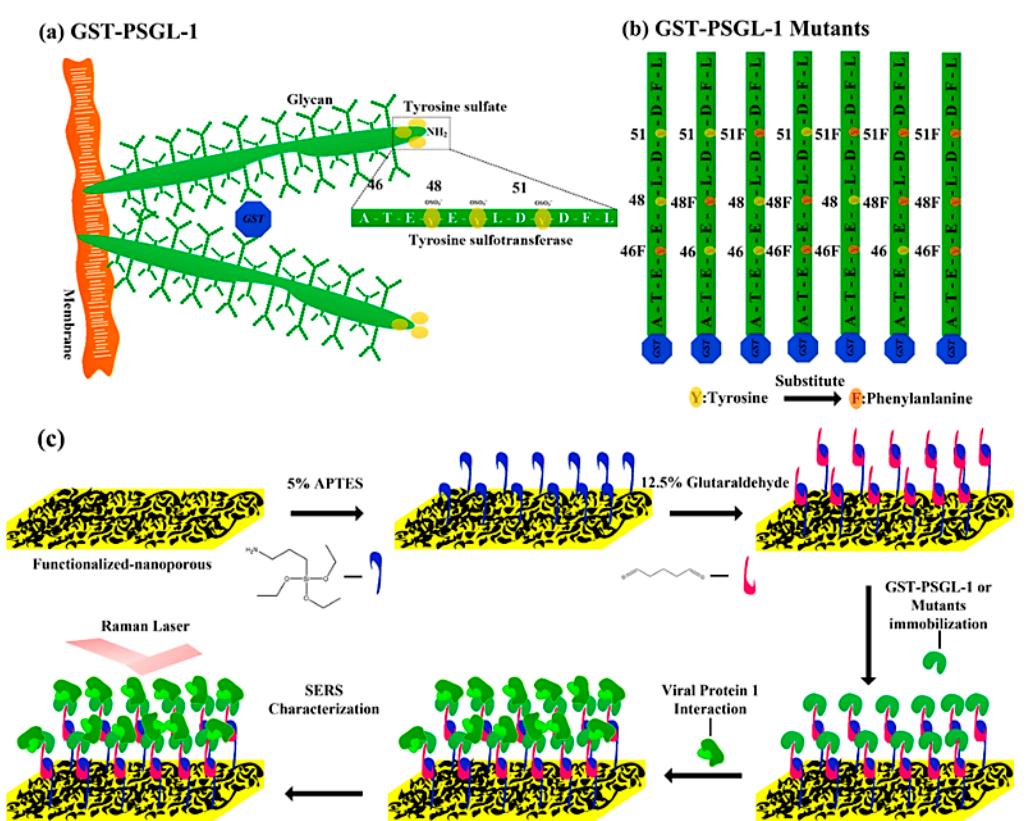
Figure 1. ( a ) The basic structure of the glutathione S-transferases fusion-human P-selectin glycoprotein ligand-1 (GST-PSGL-1) protein and ( b ) experimental design of the mutated GST-PSGL-1 protein purified are presented using GST fusion. ( c ) A schematic illustration of the experimental process for protein-protein interactions (PPIs) on the Au nanoplasmonic substrate is shown.